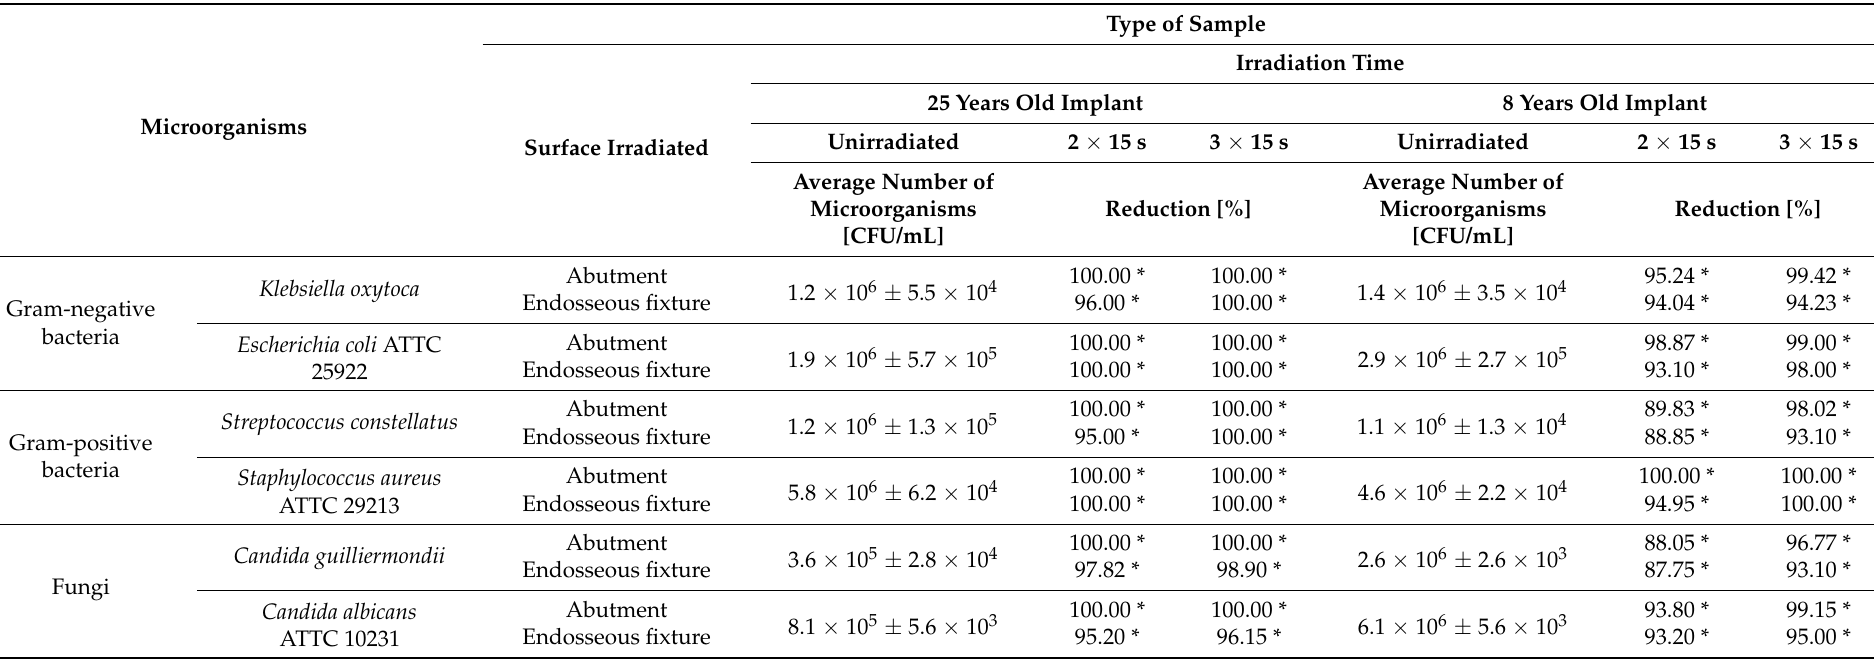
Table 4. Percent reduction in the number of pathogens isolated from the patients with peri-implantitis and from the ATTC collection after laser irradiation in 2 variants: 2 × 15 s, 3 × 15 s on the abutment and endosseous fixture 8- and 25-year-old dental